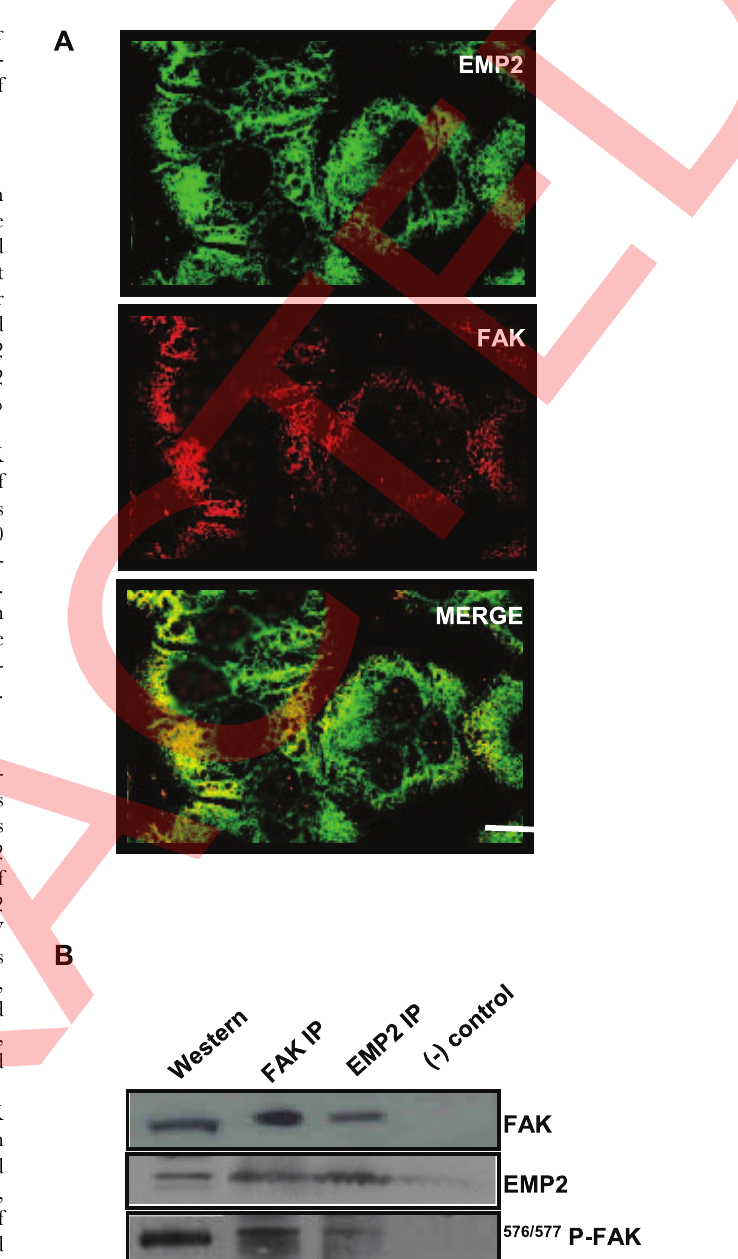
Figure 4. Total FAK and EMP2 associate with each other. (A) Cellular images of HEC-1A cells. Cells were stained for EMP2 (FITC) and total FAK (Rhodamine) expression and imaged using confocal microscopy. EMP2 and FAK colocalize (yellow) in the cytoplasm and on the membrane of HEC-1A cells. Scale bar, 20 m M. (B) In order to assess if EMP2 and FAK immunoprecipitate together, HEC-1A cells were lysed in 1% NP-40 and an interaction assessed using immunoprecip- itation/SDS-PAGE analysis. Both a -FAK antibodies and EMP2 antisera pulled down EMP2, FAK, and 576/577 p-FAK. Normal rabbit antisera served as the negative isotype control. Experiments were repeated three times with similar results; a representative image is displayed.